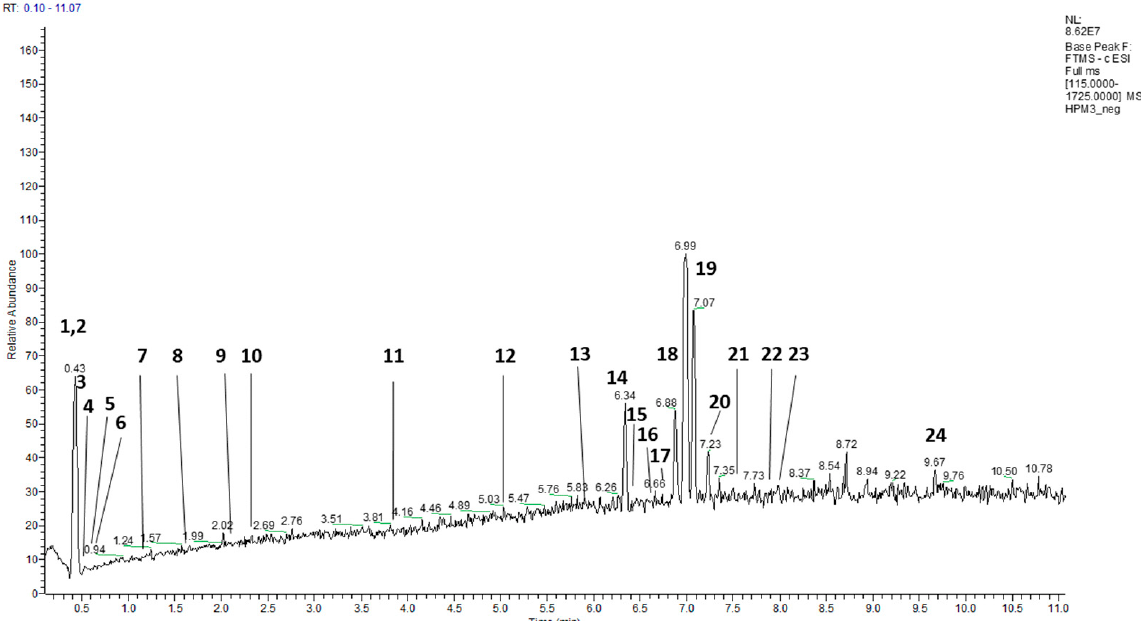
Figure 1. Characterization of the phenolic constituents of Heliotropium procubens extract by UHPLC–MS.